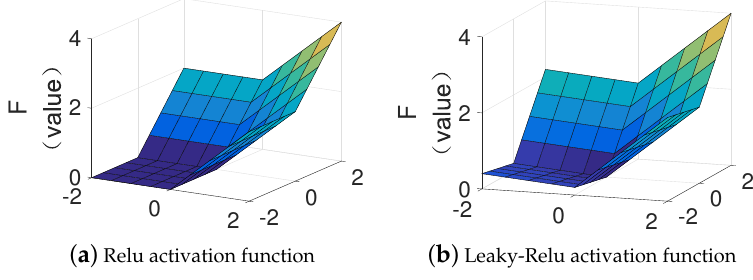
Figure 5. The Comparison of Relu and